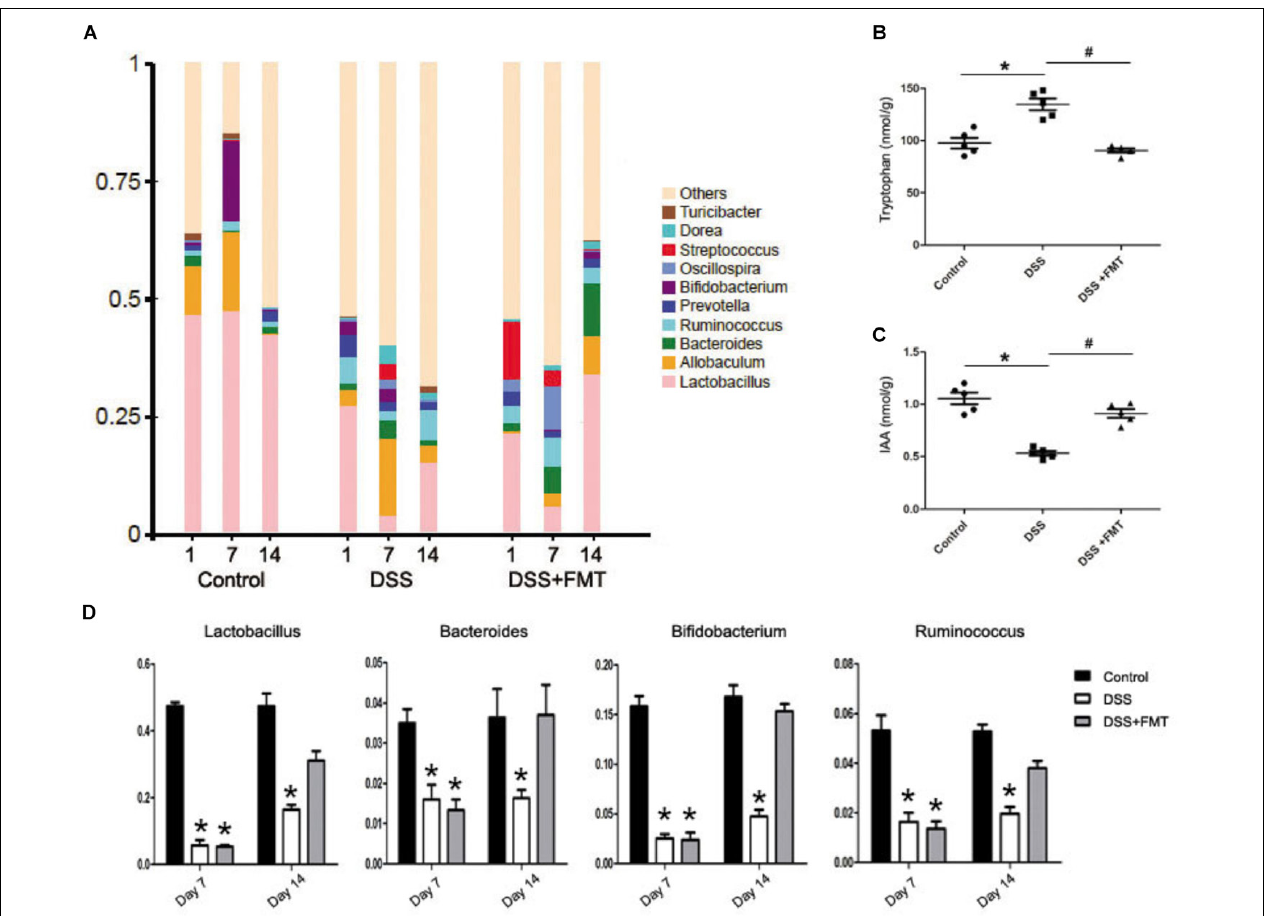
FIGURE 4 | Fecal microbiota transplantation relieved the intestinal flora disturbance of mouse colon induced by DSS. (A) Histogram representing bacterial taxonomy based on 16S rRNA gene sequencing at the genus level for colon fecal samples. (B, C) Tryptophan-derived bacterial metabolites in intestinal contents of mice force-fed with DSS. (D) Intestinal flora data are shown as the mean ± SD ( n = 6 per group). ∗ p < 0.05 compared to the control group. # p < 0.05 compared to the DSS